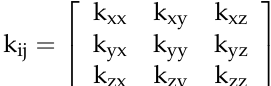
Figure 5. Internal structures of Geo 3 and 4: ( a ) Geo3, ( b )